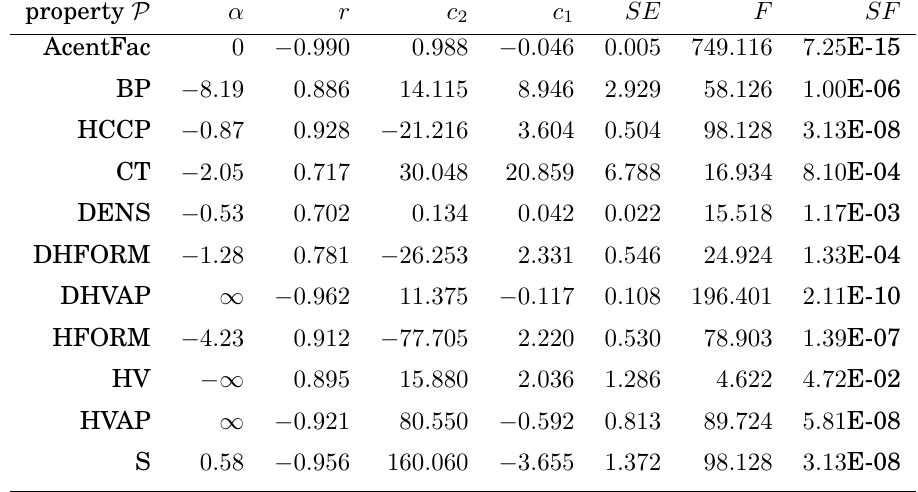
Table 3: For the physicochemical properties P reported in Figure 1: values of α that maximize the absolute value of Pearson’s correlation coefficient r . c , c , SE , F , and SF are the intercept, slope, standard error, F -test, and statistical 2 1 significance, respectively, of the linear QSPR models of Equation